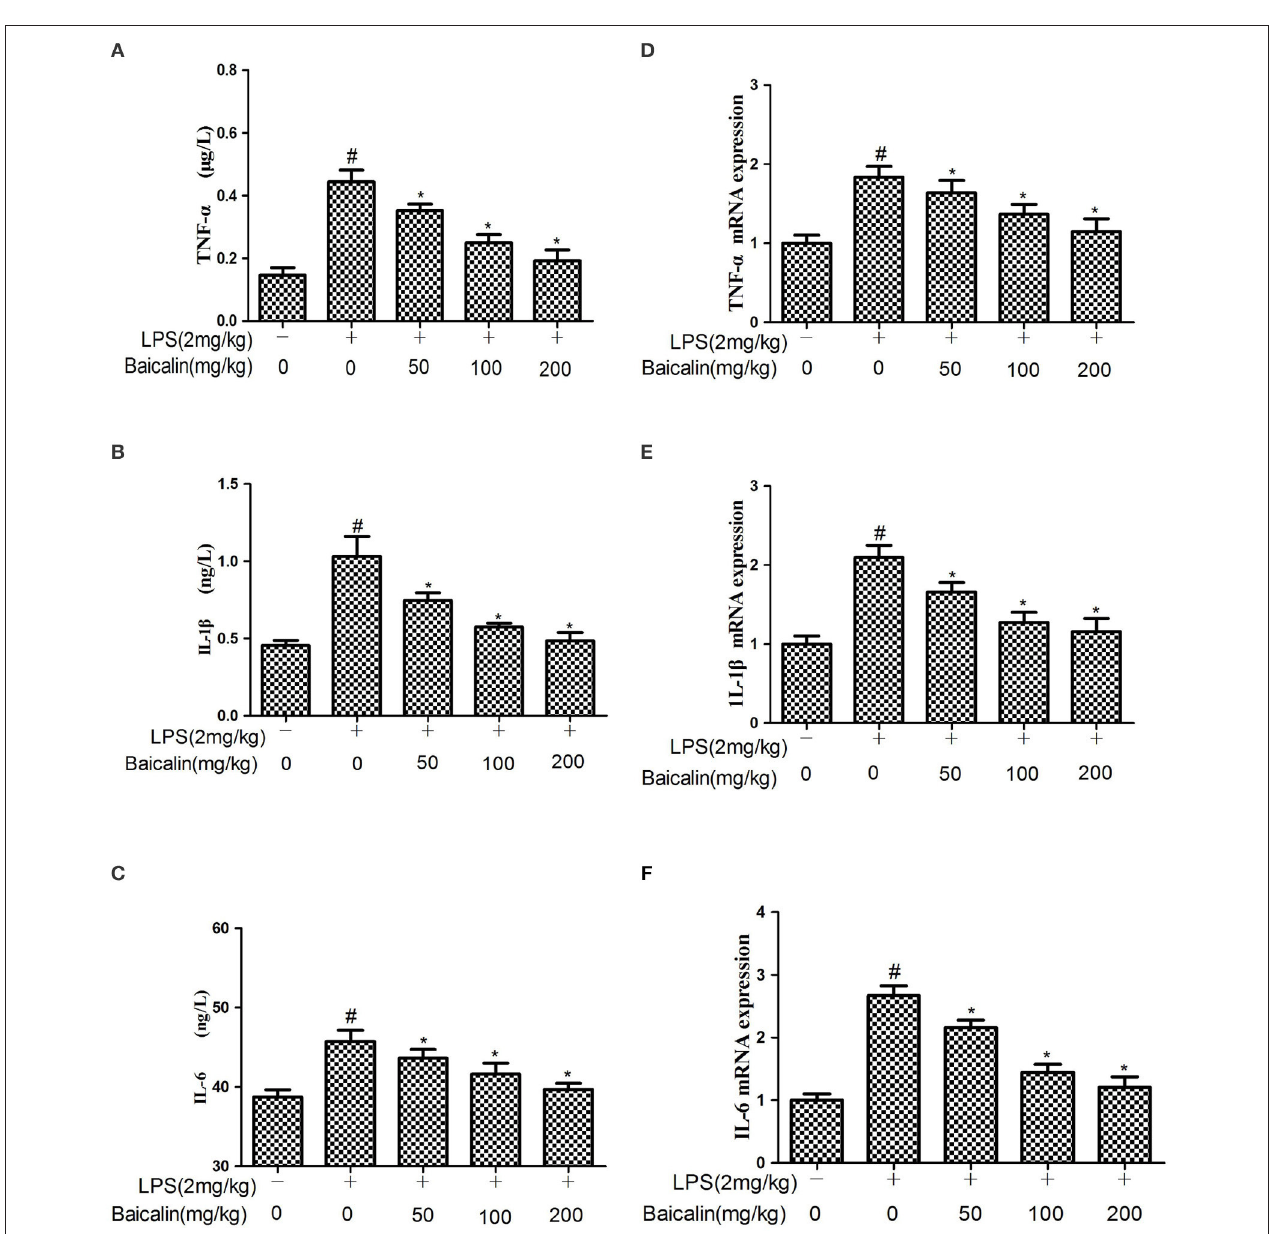
FIGURE 4 | Effects of Baicalin on the production of cytokines. (A–C) The expression of TNF- α , IL-1 β and IL-6 proteins induced by LPS. (D–F) The expression of TNF- α , IL-1 β and IL-6 mRNA induced by LPS. Data are expressed as the mean ± SD ( n = 10). * P < 0.05vs. LPS group; # P < 0.05vs. control